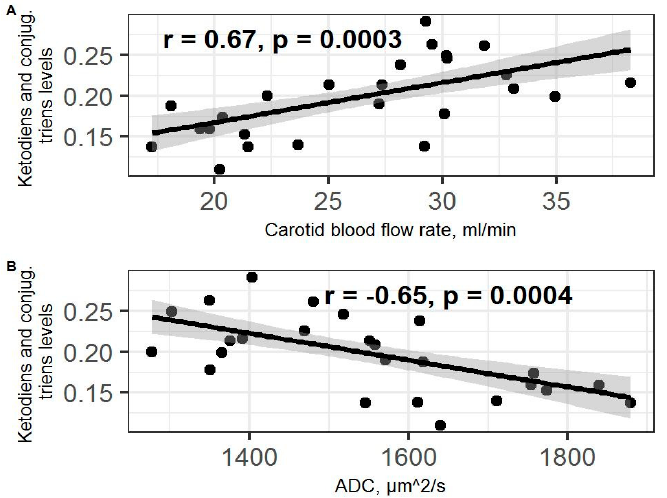
Figure 9. ( A ) Spearman correlation between blood flow values and ketodiens and conjugated triens level in PSS rats. ( B ) Spearman correlation between ADC values and ketodiens and conjugated triens level in PSS rats. Gray area around the line represents the 95% confidence interval.